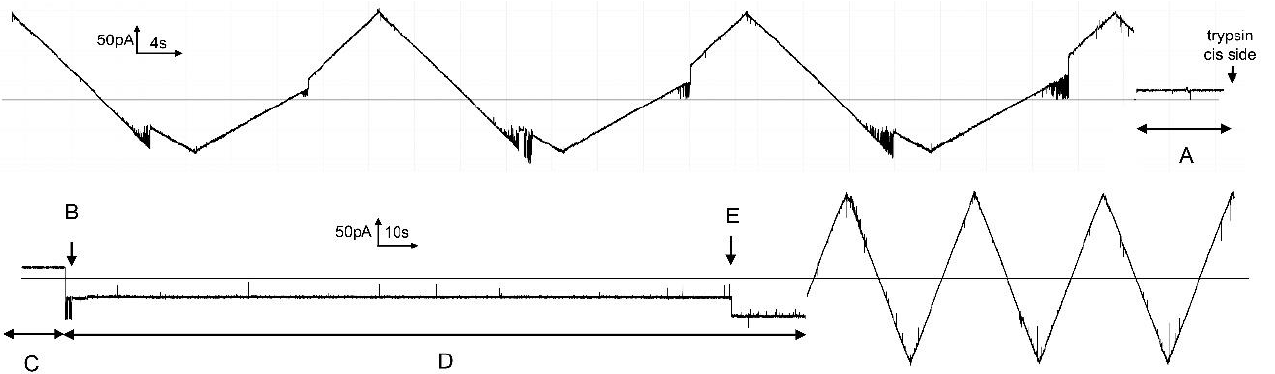
Figure 10. Trypsin cleavage of the sensor of subunit 2. The upper trace shows the gating of subunits 2 and 3 of a single Triplin in response to a triangular voltage wave (+/ − 80 mV). In region “A” , 10 mV was applied prior and during treatment with 20 µ g trypsin added to the cis side. After 10 min of exposure to trypsin (region “C”) , −36 mV was applied (region “D”). Subunit 2 closed almost immediately (“B”). At point “E” , subunit 2 opened and the subsequent application of a triangular voltage wave resulted in no gating.